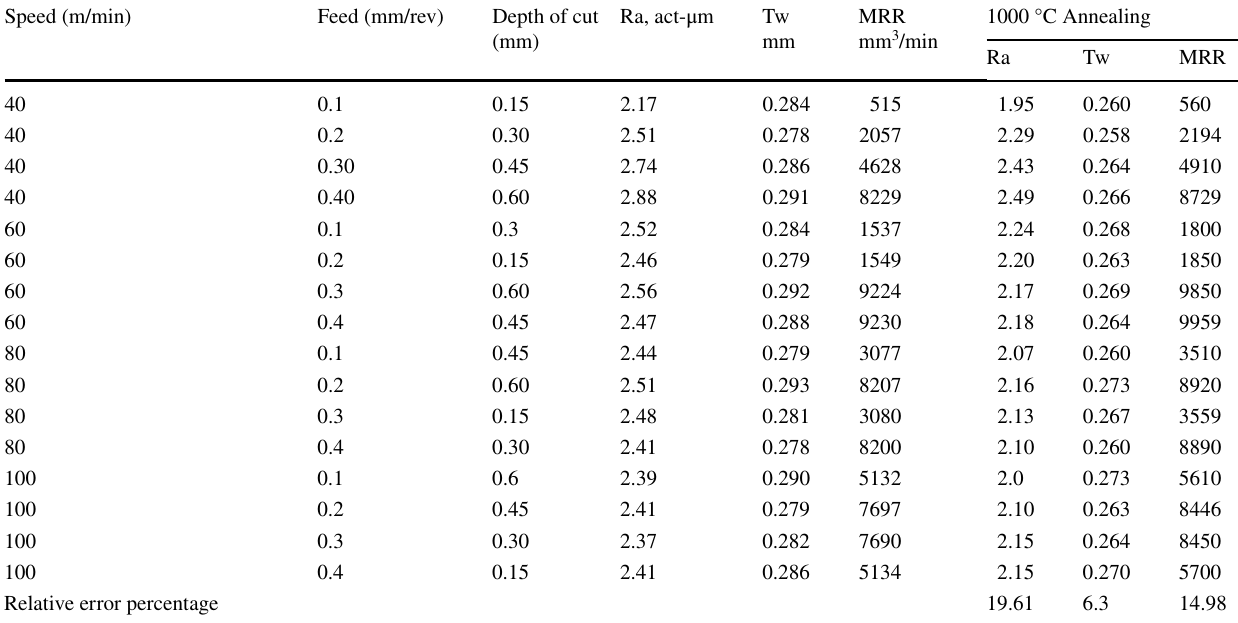
Table 4 Measured data Speed (m/min) Feed